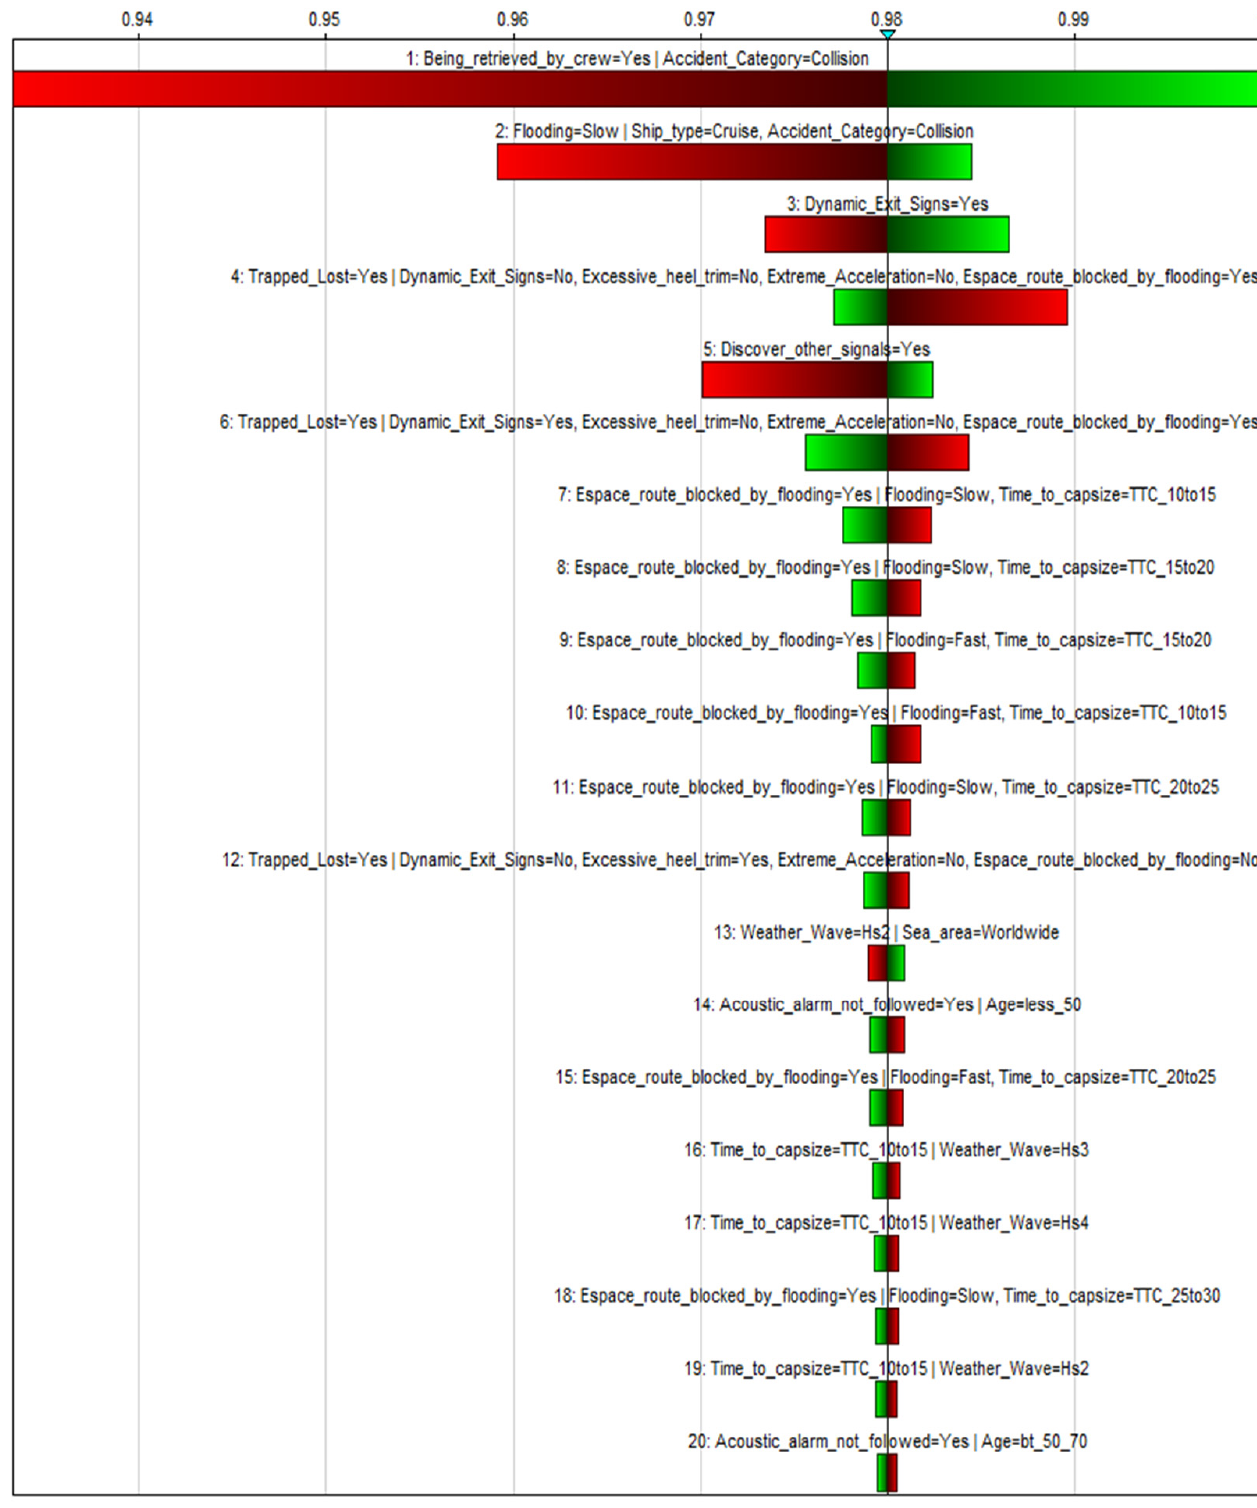
Figure 9. A tornado chart (generated from the GeNIe modeler) of the Bayesian network referring to the mustering process, by assuming Dynamic Exit Signs, for 100% of the spread for the calculated value. Table 4. Results for Δ R (lives saved per ship/lifetime) for the RCO considered, per accident type and in total.